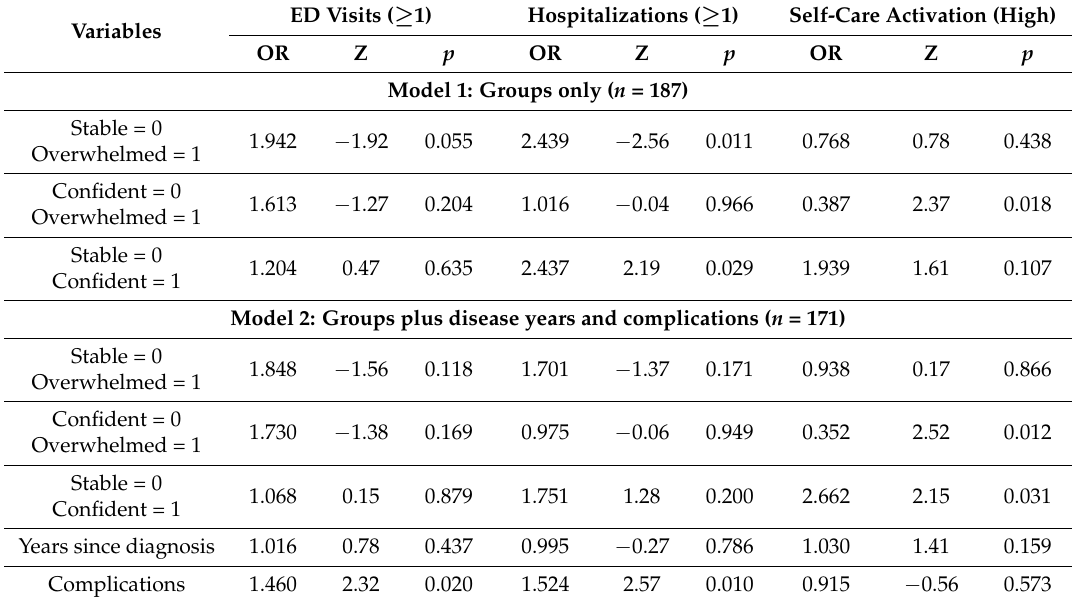
Table 3. Logistic regression